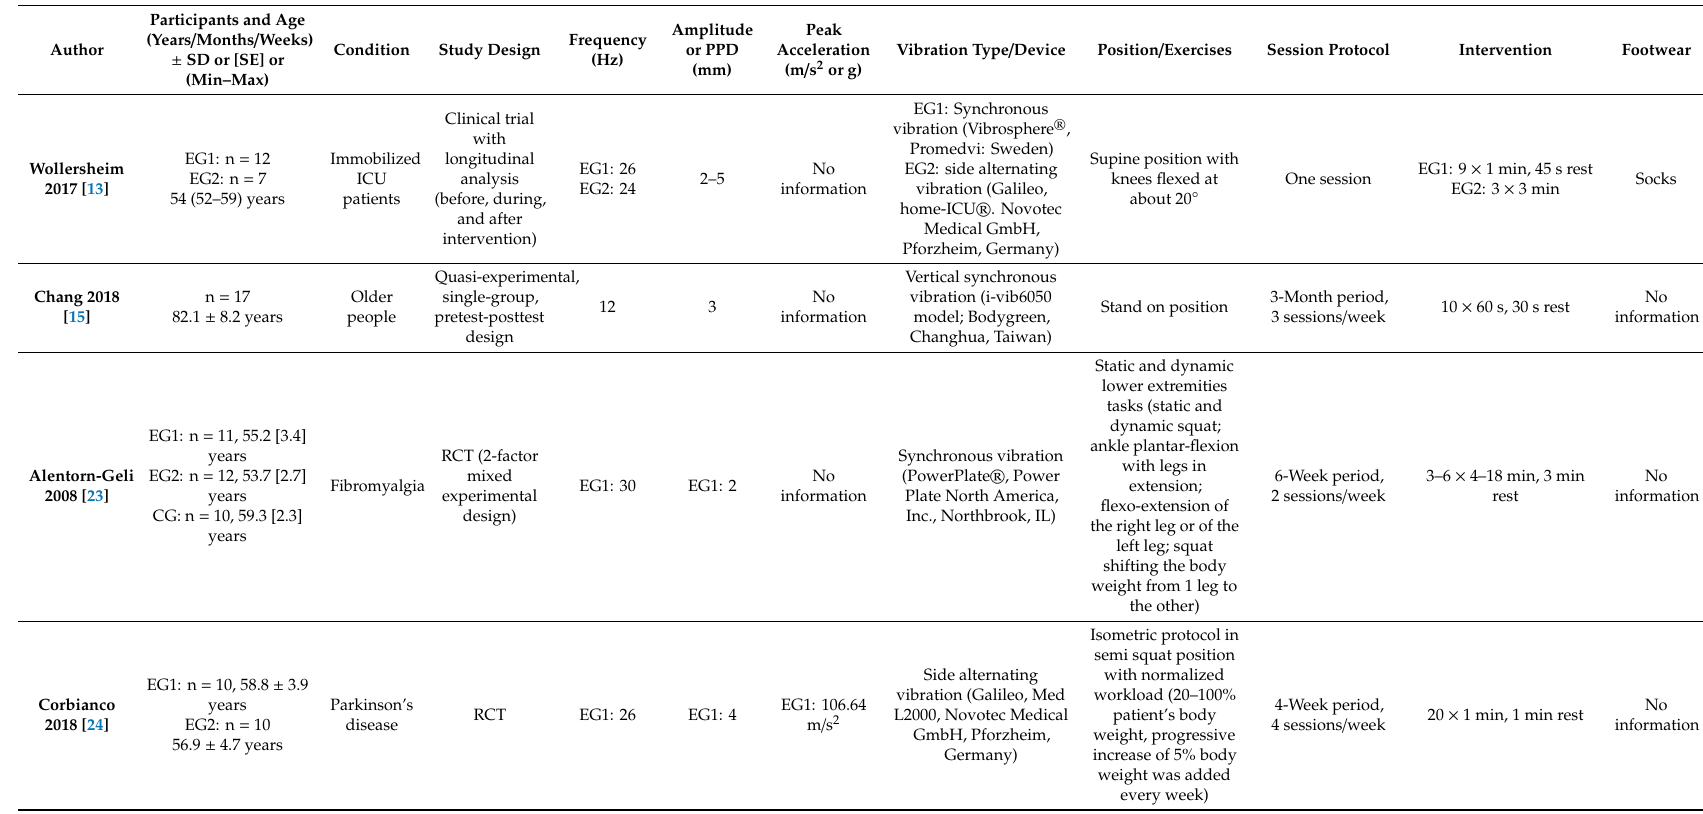
Table 1. Intervention parameters in the included